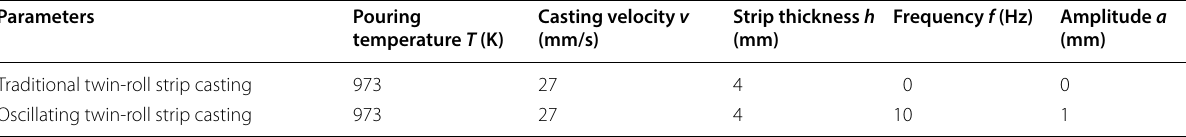
Table 2 Experimental table of traditional twin-roll strip casting and oscillating twin-roll strip casting Parameters Pouring temperature T